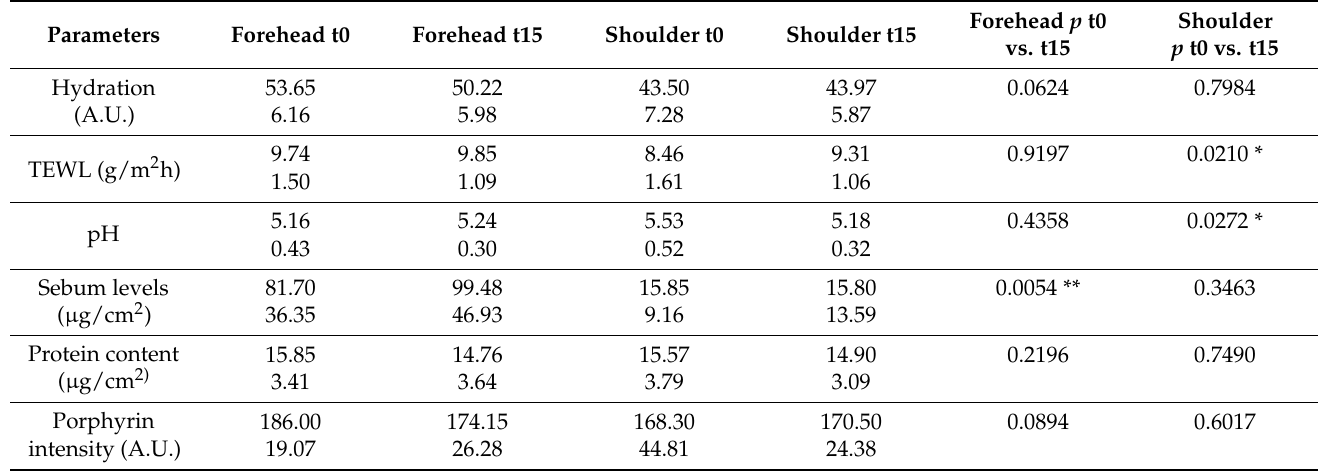
Table 2. Results concerning instrumental analysis of skin parameters taken at time zero and after 15 days both on the forehead and on shoulder area expressed as a mean and standard deviation.